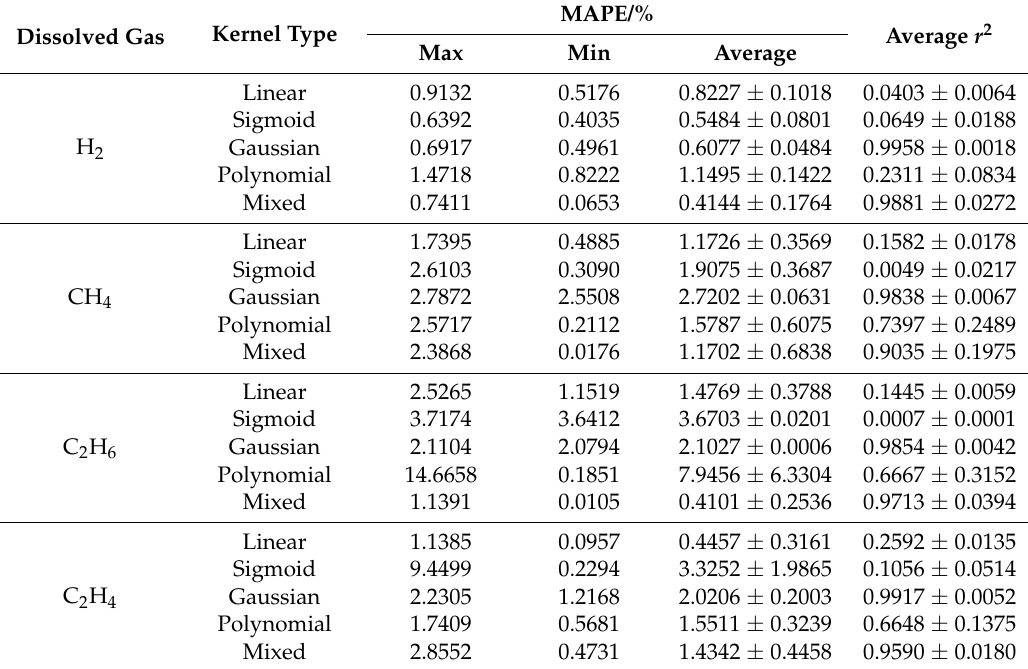
Table 3. The average forecasting performance of the training set (Case 1, 50